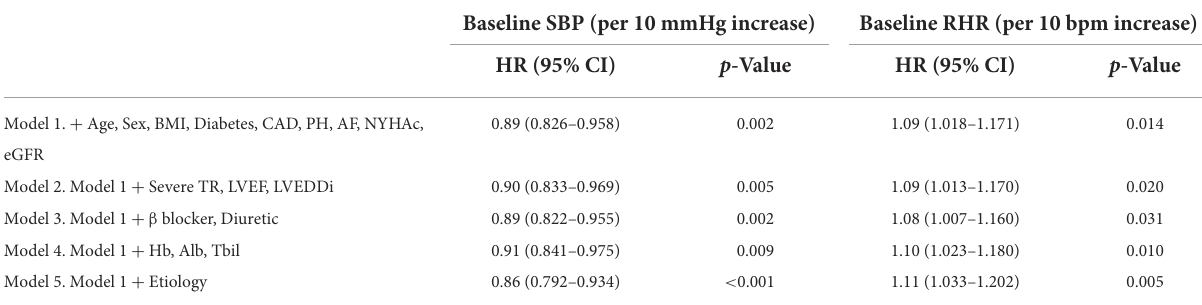
TABLE 3 Combined models of BPs and RHR for all-cause mortality. Combined models of SBP and RHR for all-cause mortality; N = 2013, 165